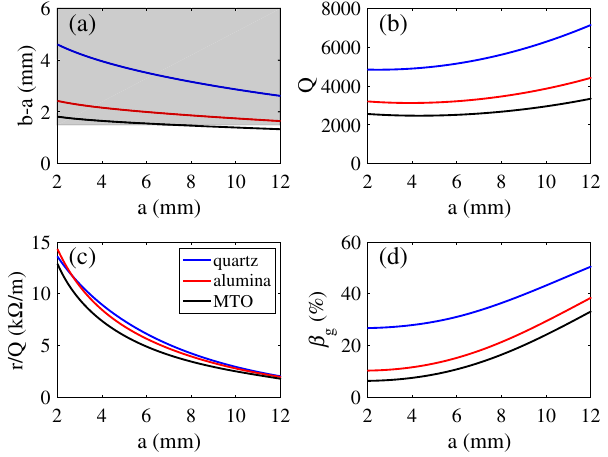
FIG. 2. Properties of the uniform DLS section as a function of the inner radius for different dielectric materials. (a) Dielectric wall thickness. (b) TM 01 quality factor. (c) TM 01 r=Q . (d) TM 01 group velocity.